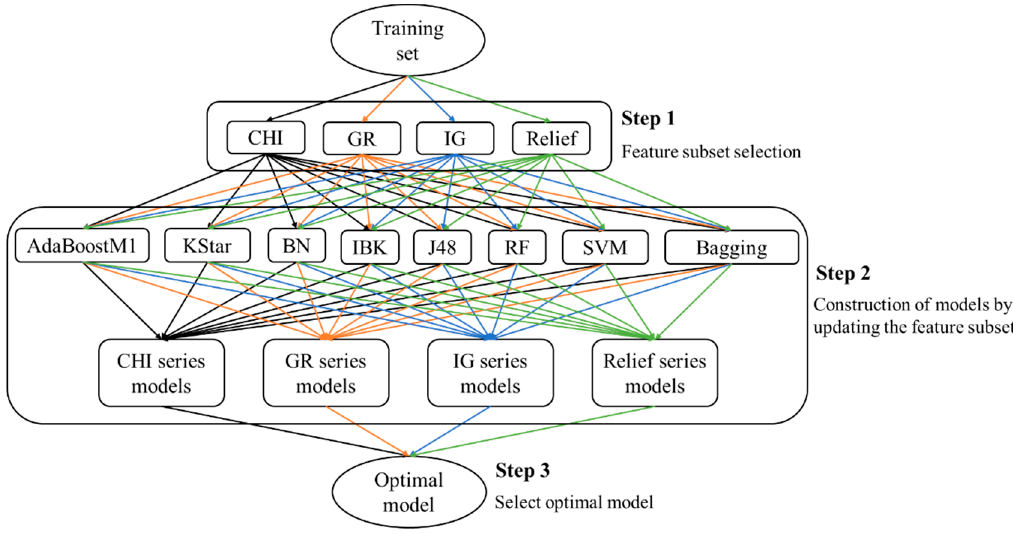
Figure 4. The workflow of optimal model selection.